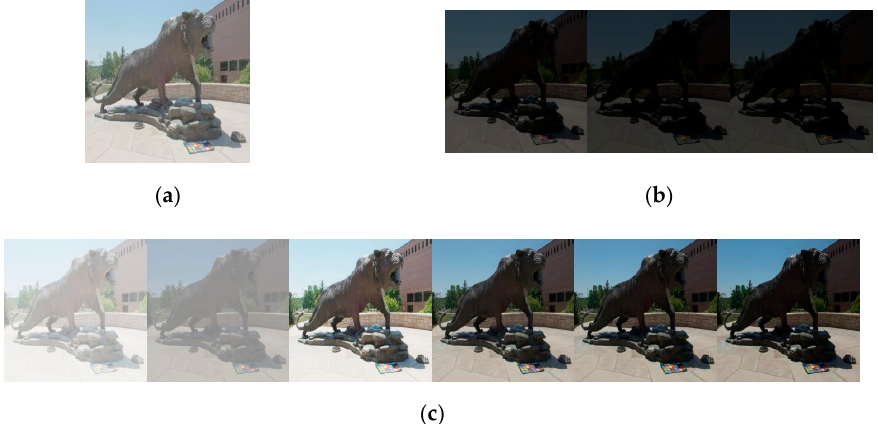
Figure 2. Data organization for the experiment: ( a ) source data, ( b ) exposure value (EV) data [18], and ( c ) gamma shift data.